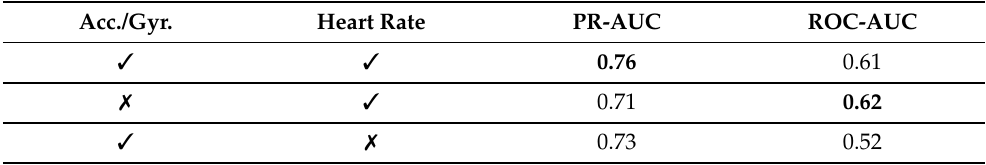
Table 9. Ablation study on the feature modalities (heart rate, accelerometer and gyroscope, or both) used, for the CNN-AE